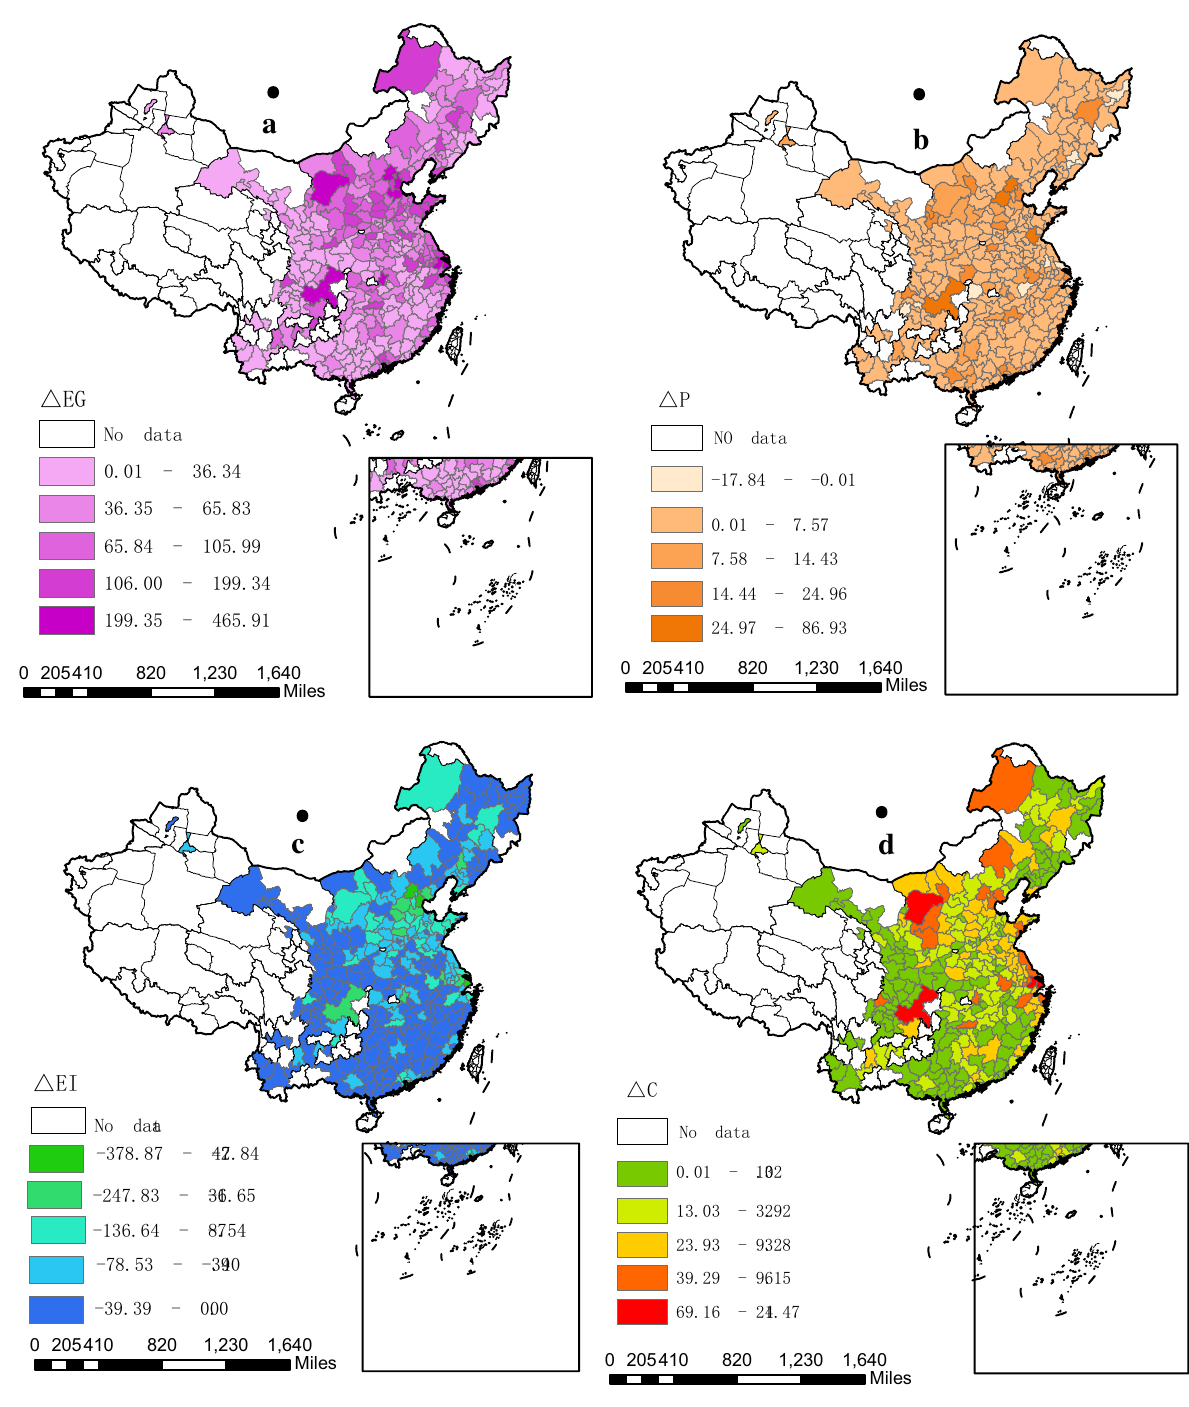
Figure 4. Spatial distribution of drivers of China’s city-level carbon emission increment during 1992–2017 (unit: million tons). ( a ) The contribution of economic growth to emission increment; ( b ) The contribution of population size to emission increment; ( c ) The contribution of technological progress to emission increment; ( d ) The emission increment of each city. Notes : (1) The gross domestic product (GDP) and population data of each city are from China City Statistical Yearbook, the statistical yearbook of each city, and the government bulletin. A few missing values have been supplemented by interpolation method. (2) Because of the lack of population and GDP data for some cities, 285 cities are covered here, excluding Hong Kong, Macao, and Taiwan. (3) These images were made by ArcGIS 10.0. The version is available from: https ://www.esri.com/en-us/arcgi s/produ cts/ arcgi s-maps-for-offic e/downl